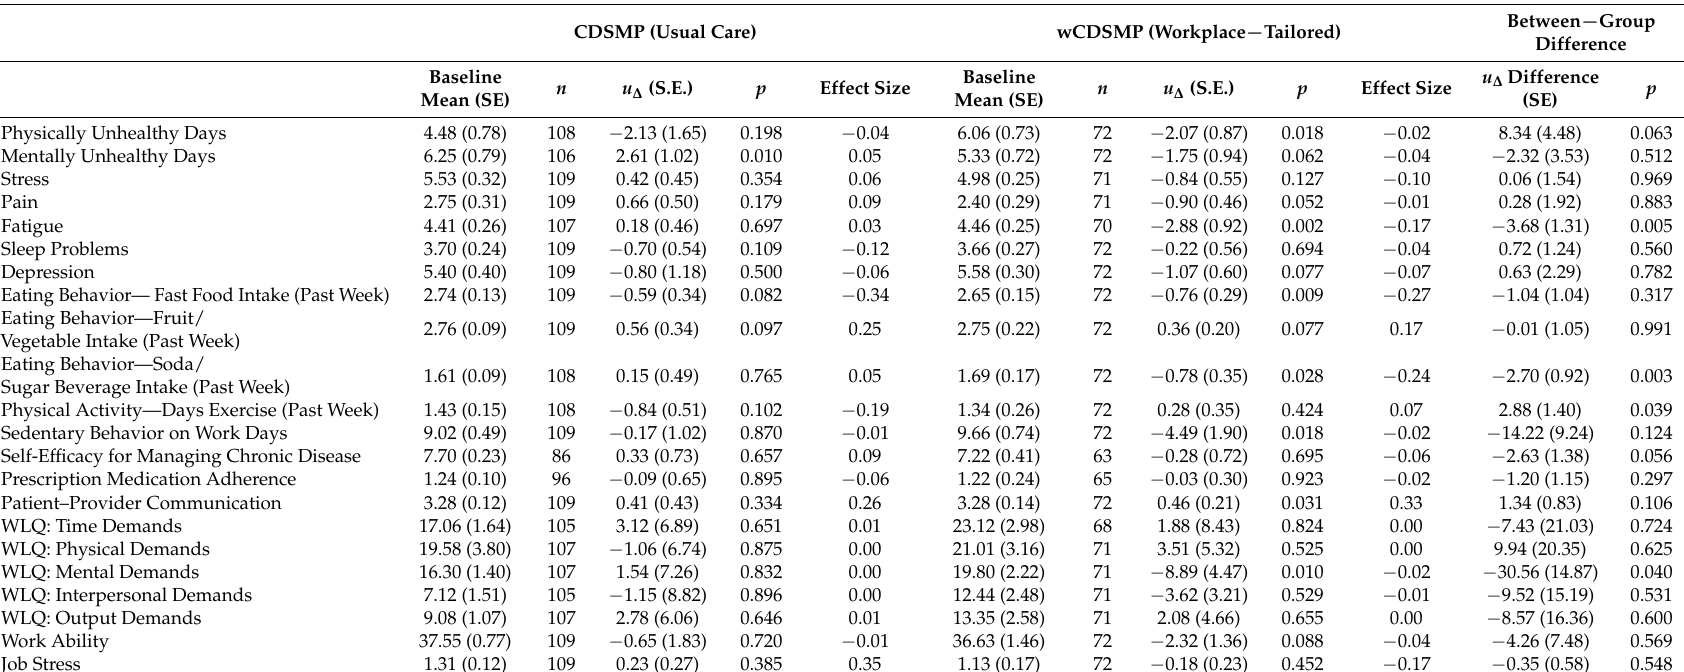
Table 3. Latent change regression